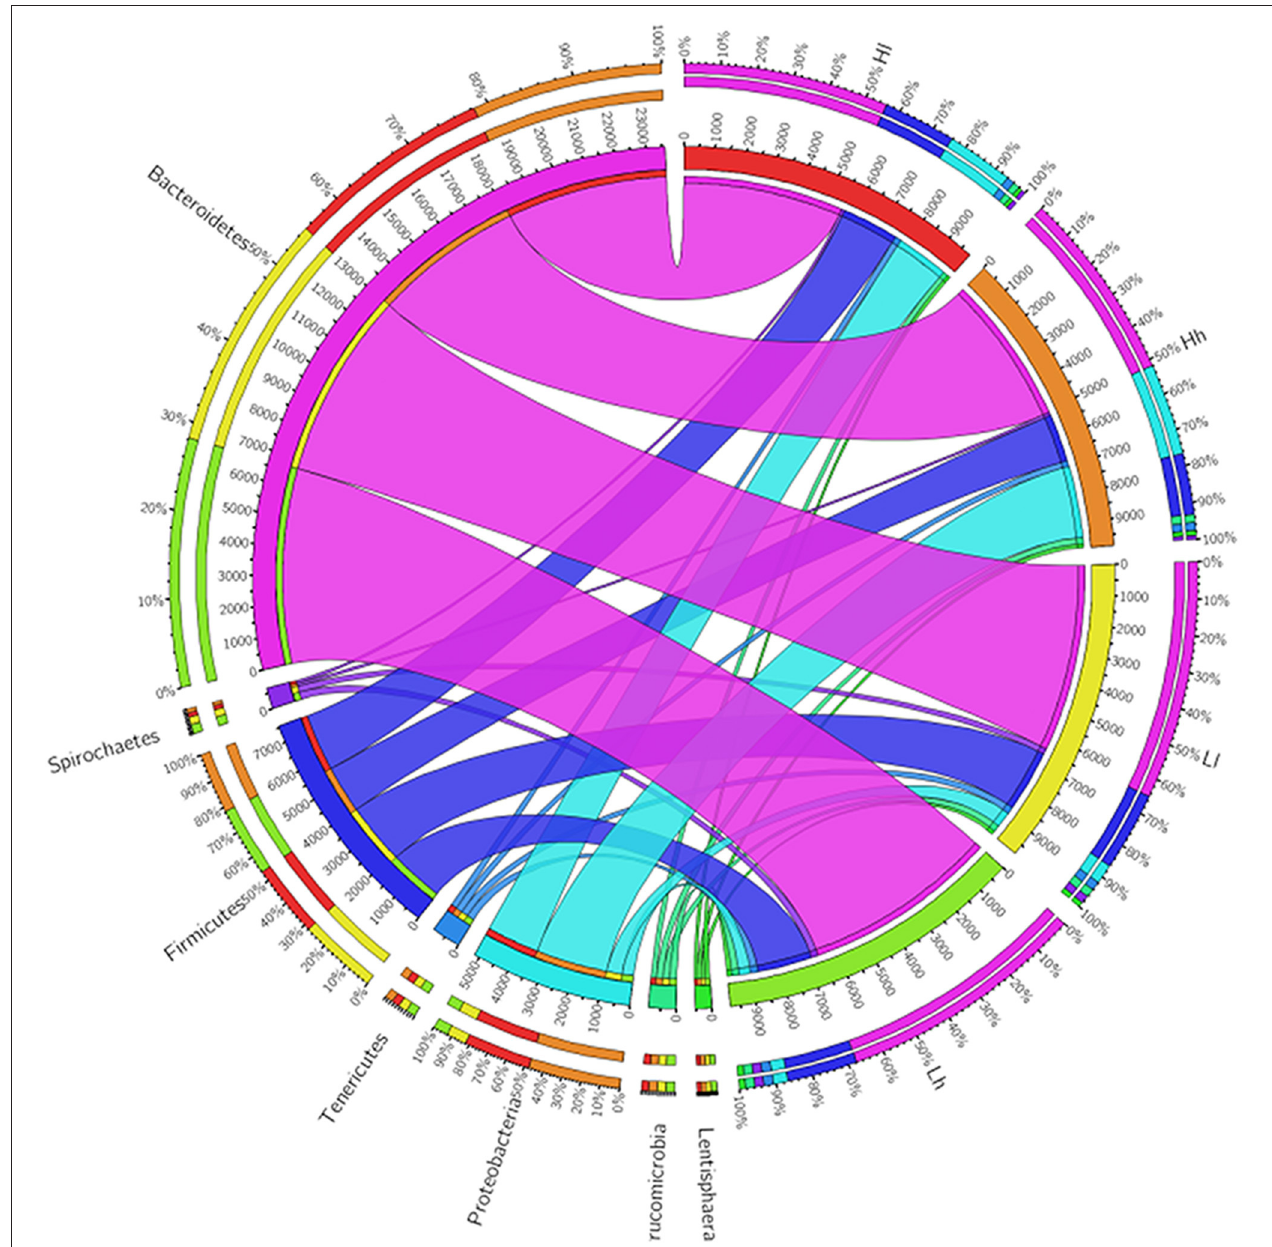
FIGURE 7 | Circos showed Bacterial phyla of 4 the